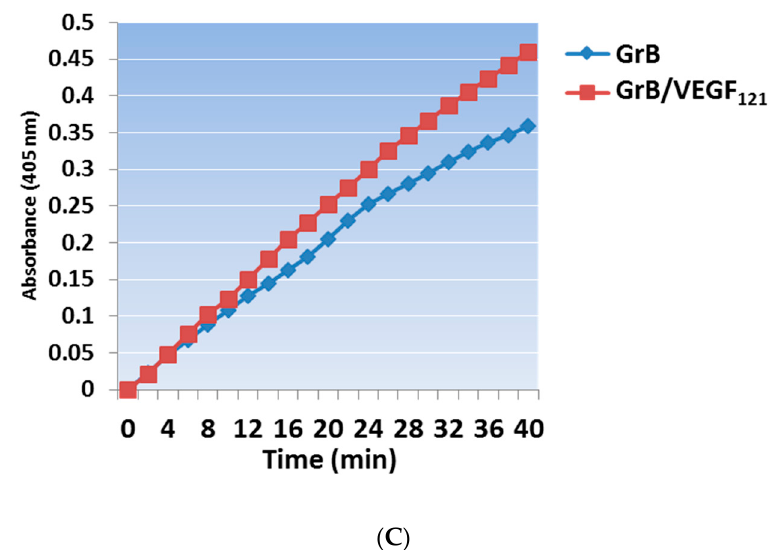
Figure 1. Construction, expression and purification of Granzyme B (GrB)/VEGF 121 . ( A ) The Granzyme B/VEGF 121 cassette includes an N-terminus leader peptide for secretion of the protein into the conditioned media, followed by a His 6 -tag and a peptide sequence recognized by enterokinase. The cassette is inserted into the mammalian expression vector pSecTag. ( B ) pro-GrB/VEGF 121 , purified by metal affinity chromatography, is activated by removal of the His 6 -tag by enterokinase. ( C ) The resulting 80 kDa dimer has the equivalent enzymatic activity of free Granzyme B.